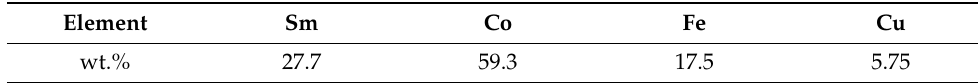
Table 1. Metal contents in spent SmCo magnets.